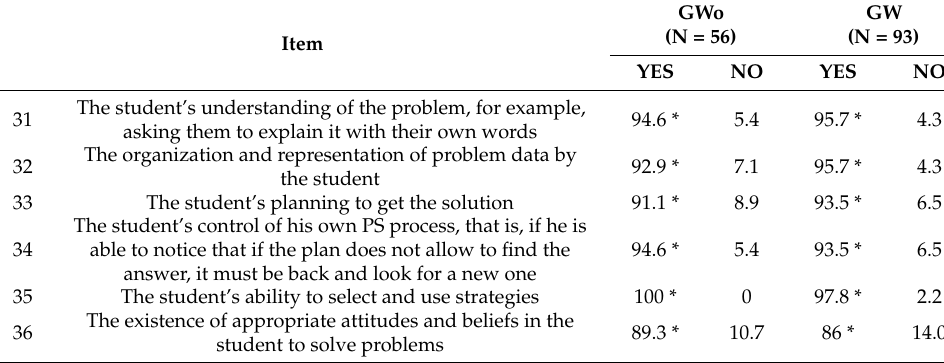
Table 7. Percentages of responses of knowledge of assessment in PS